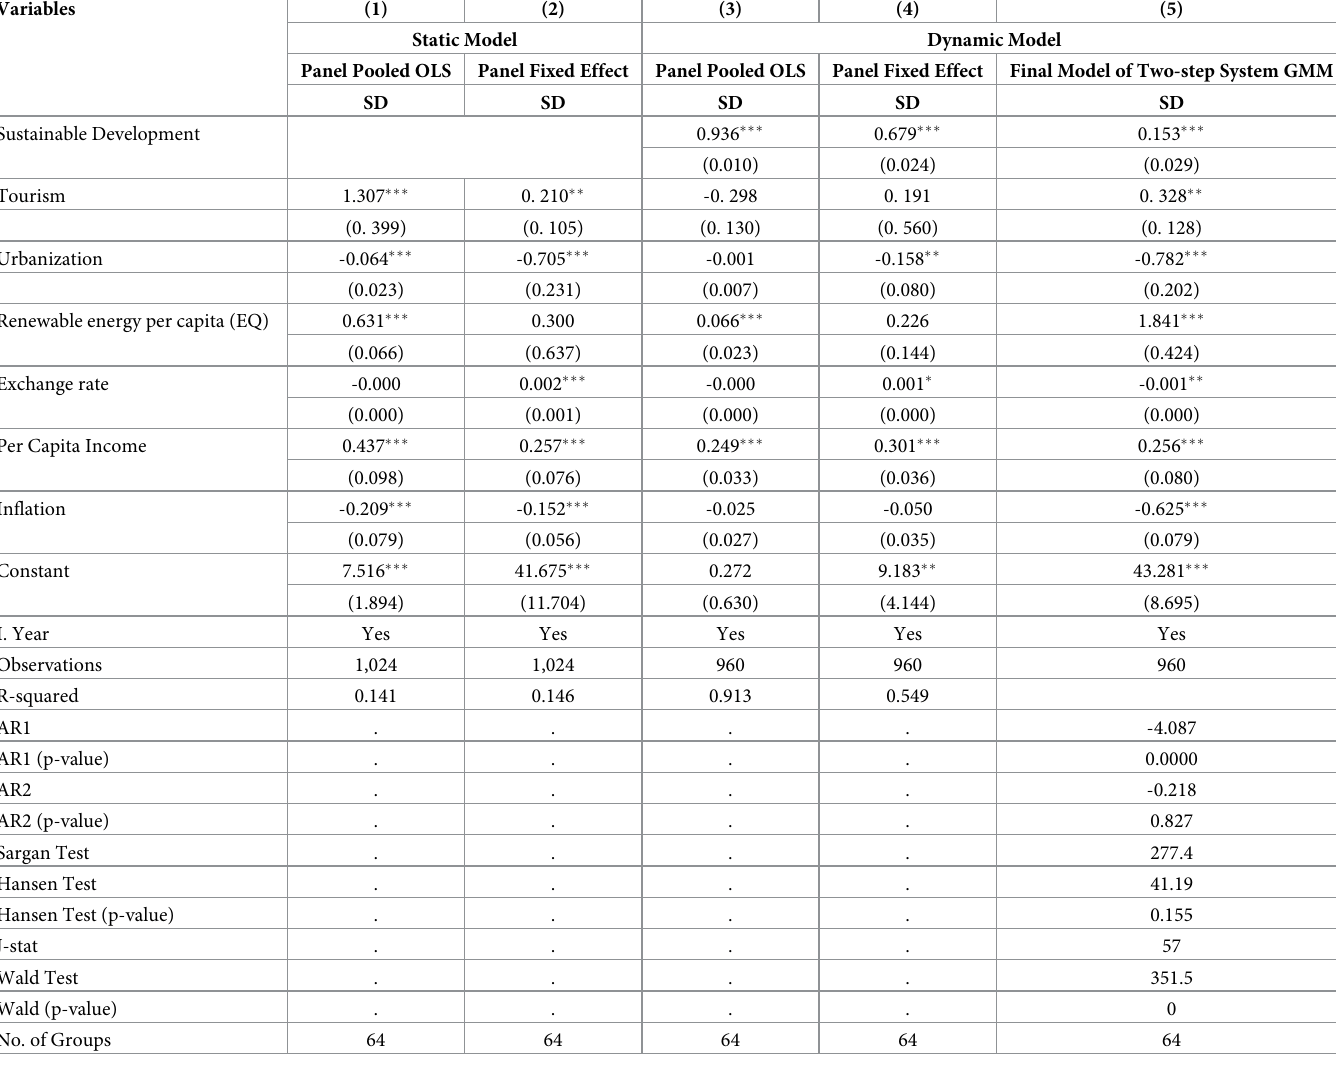
Table 6. Robustness check of factors afffacting sustainable development results–direct